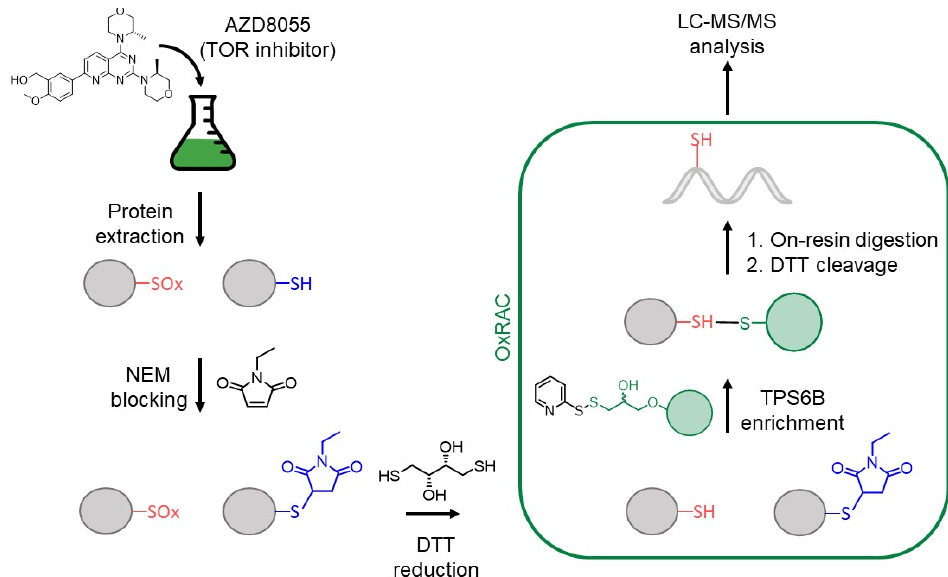
Figure 1. Workflow for proteomic oxidative cysteine analysis of C. reinhardtii with AZD8055 treatment. After protein extraction, reduced cysteine thiols are blocked with N -ethylmalemide (NEM), before reversibly oxidized cysteines are reduced using dithiothreitol (DTT). An oxidized cysteine resin-assisted capture method (OxRAC) is used to enrich proteins containing oxidized cysteines and samples are processed for bottom-up liquid chromatography—tandem mass spectrometry (LC-MS / MS) analysis.